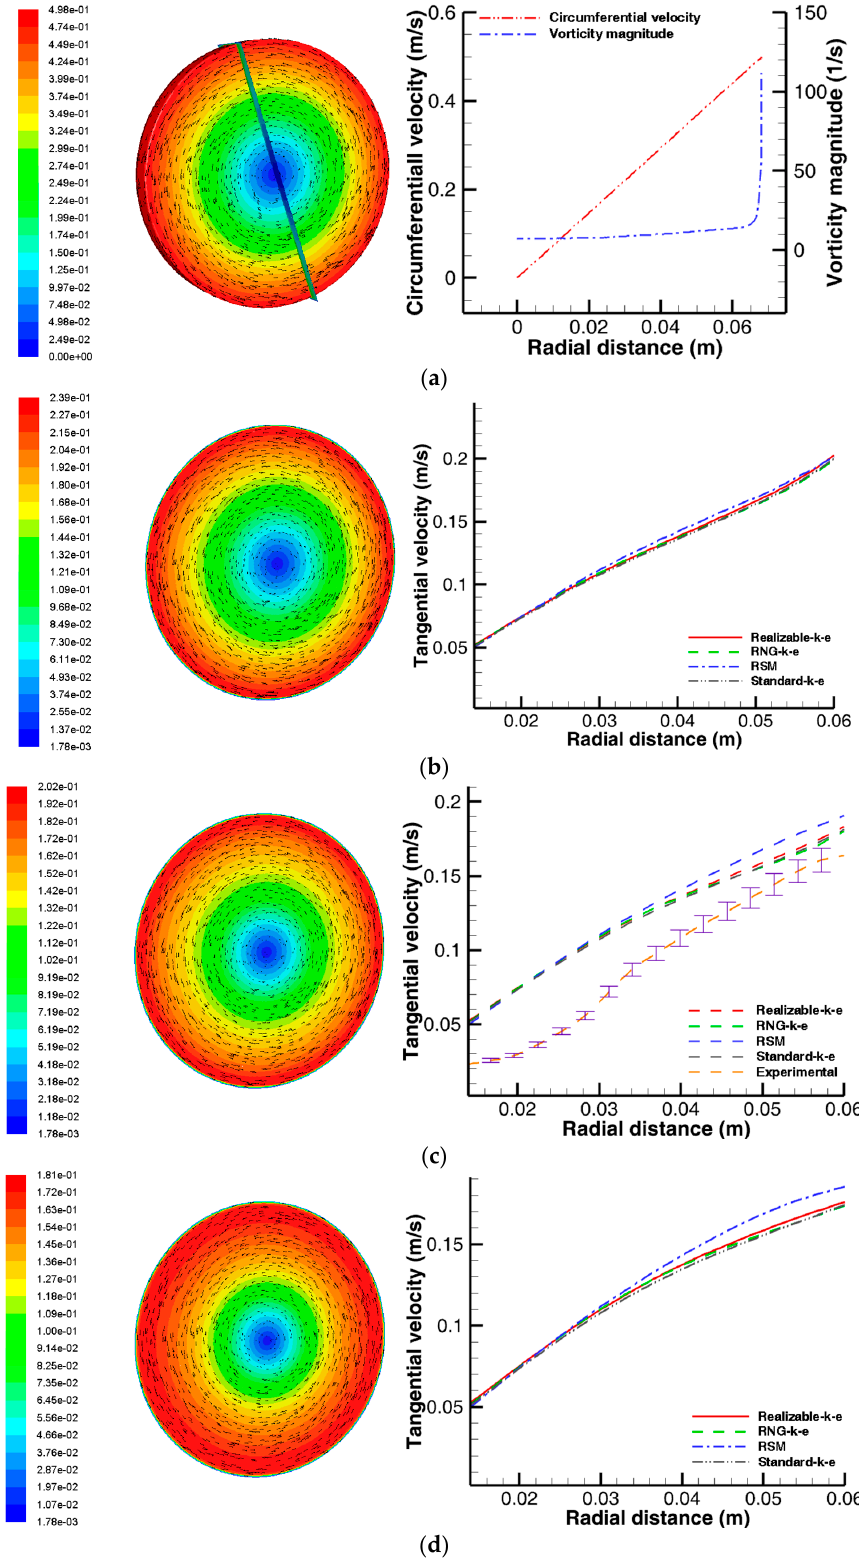
Figure 5. Reactor cross sections showing the velocity vector fields and contours for the RNG- k - ε model and the radial tangential velocity profiles along the Y-Z plane at N = 70 rpm: ( a ) rotating disc boundary layer; ( b ) x = 0.0015; ( c ) x = 0.003725; ( d ) x = 0.006.